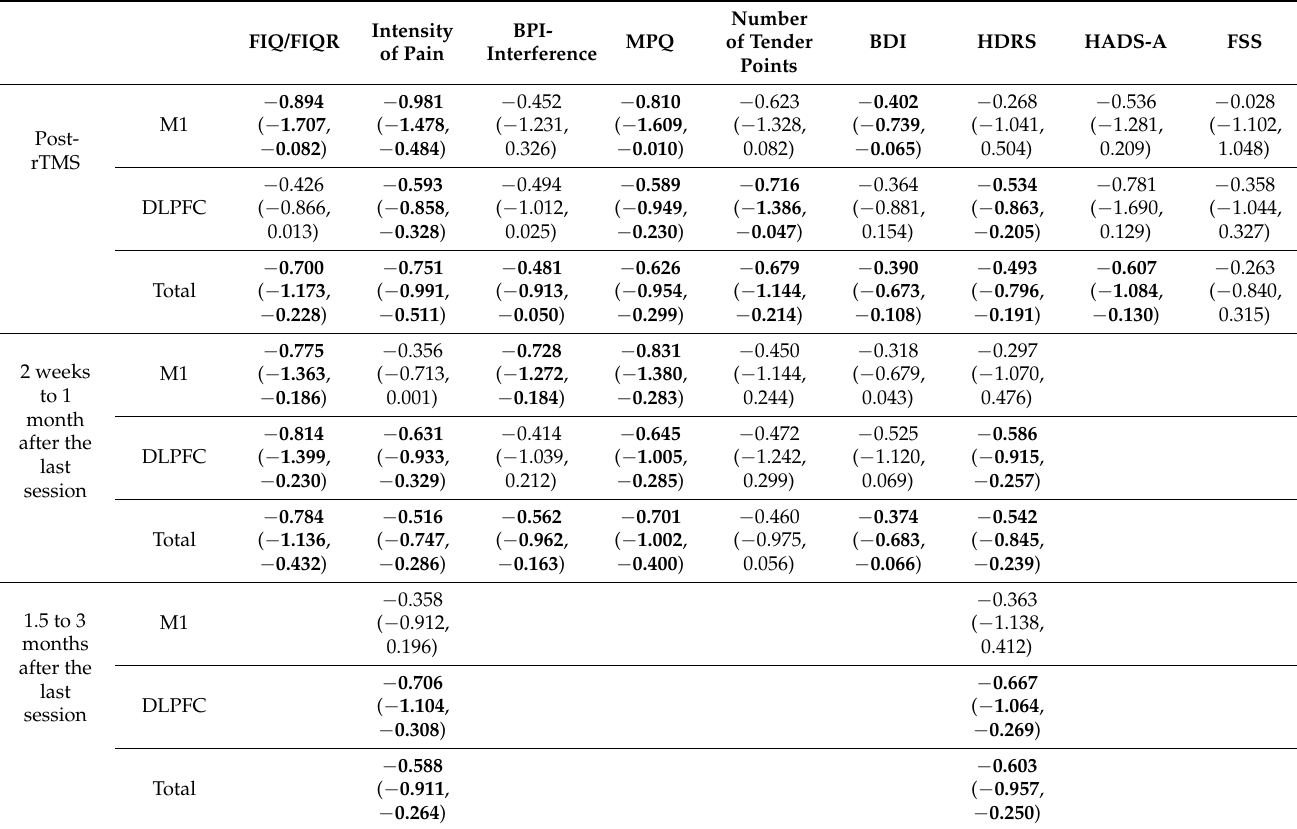
Table 3. Subgroup analyses by stimulation site.